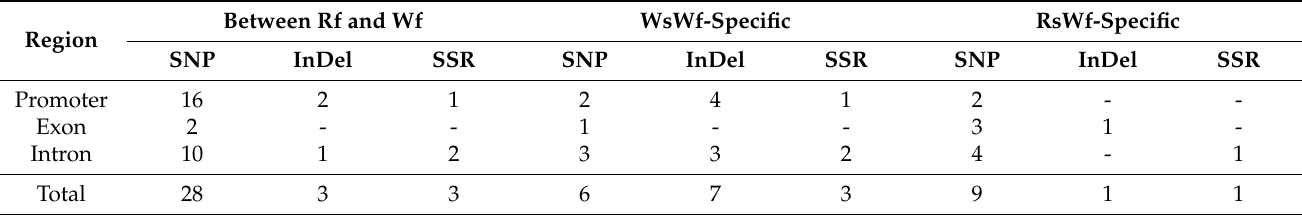
Figure 3. Schematic representation of genomic DNA of RsTT8 genes with primer position for cloning ( A ) and genomic organization of cloned RsTT8 genes ( B ). ( A ) Exon and intron are represented by box and solid line, respectively. I and E indicate intron and exon, respectively. Arrows indicated primer position and direction with forward (F) and reverse (R). ( B ) Genomic organization of cloned RsTT8 genes with promoter regions and 7 exons (box) and 6 introns (solid line). Numbers indicated nucleotide sequence (bp), and InDel and SSR regions were also marked. MRE, MYB-recognition motif; BRE. bHLH-recognition motif. Arrows named p Bam HI and p Nco I indicated primers for promoter::GUS construction. Four boxes of dotted red lines indicate regions used in marker validation: PS-P, region amplified by promoter-specific primer set ( − 979~ − 818) (Rf-P/Wf-P in Table S1); ID-P, region amplified by 14 bp InDel-discriminating primer set; SSR-P, region amplified by TC SSR including primer set; WD/AD-P, region amplified by primer set that discriminated one CAT InDel and three SNPs (Rf/Wf-P in Table S1). Table 1. List of polymorphisms found in RsTT8 genes.